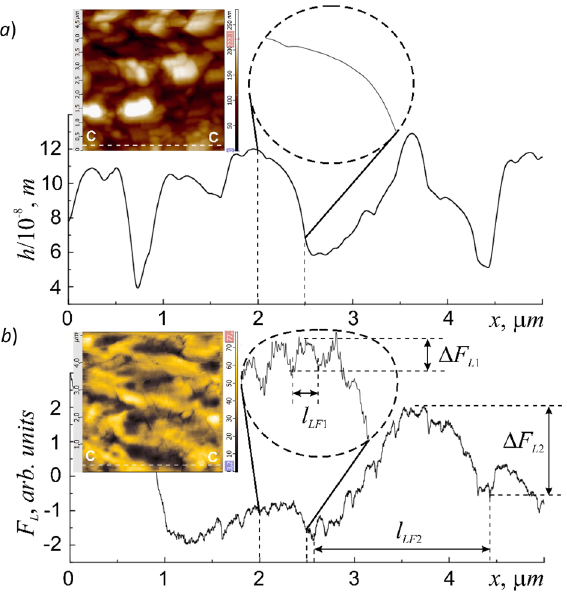
Figure 6. Profiles of cross-sections 5 × 5 μm of the surface area: relief h = h (x) ( a ), and LF-signal F L = F L (x) ( b ). The insets show their bitmap